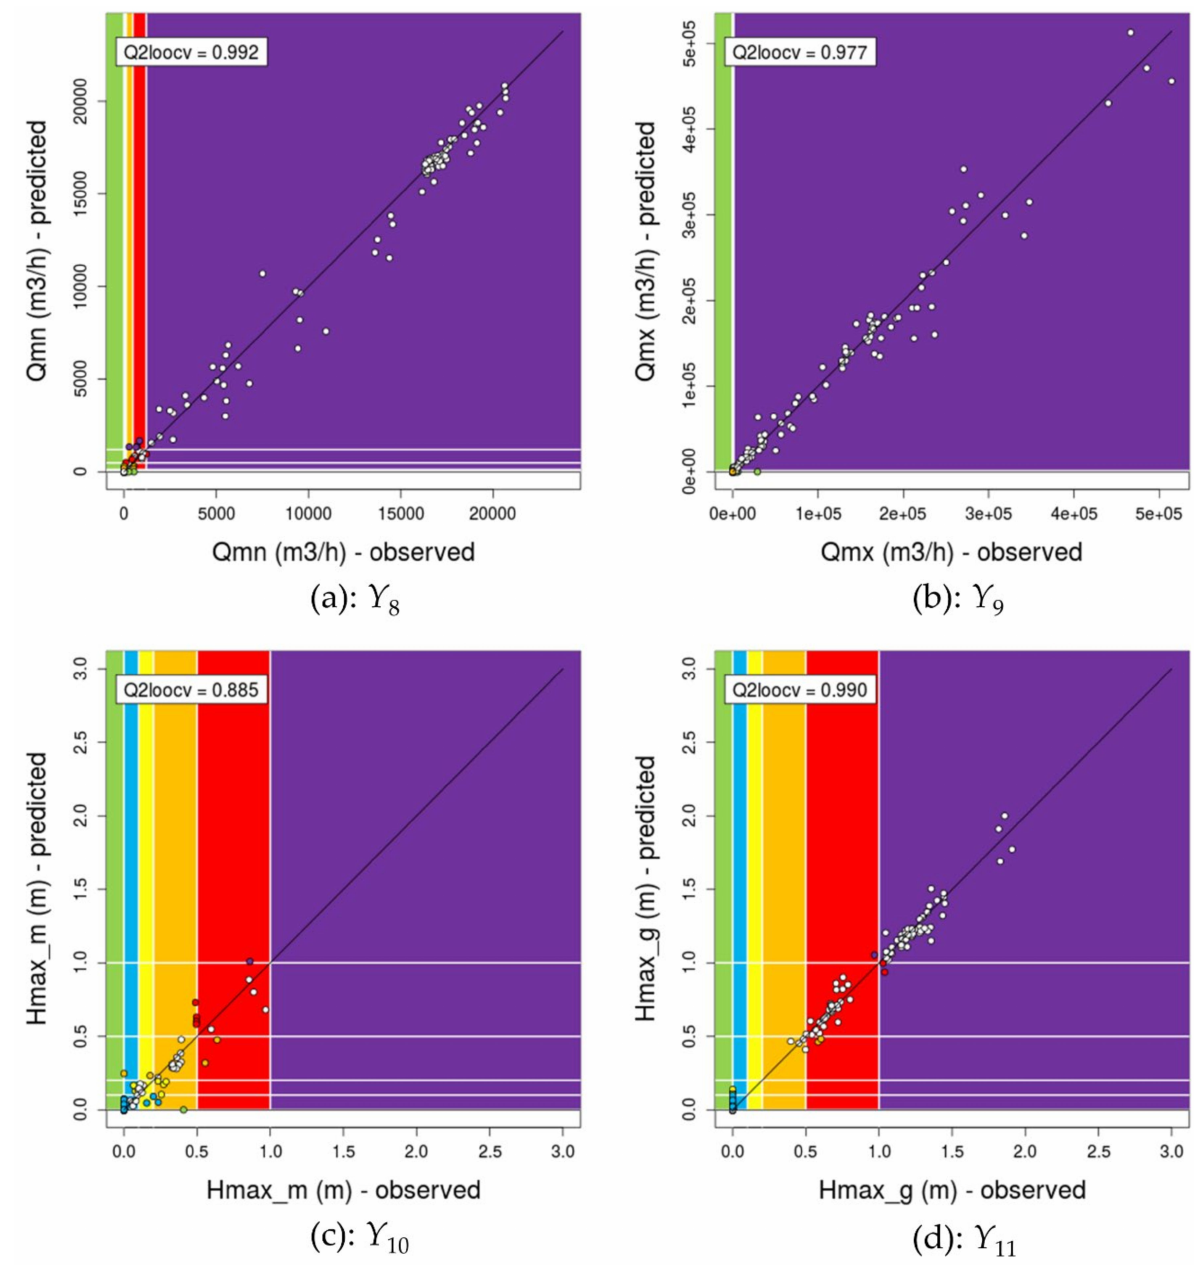
Figure A2. Cross-validation of the Y 8 –Y 11 metamodels: comparison between the observations (the numerically calculated Y values) and the predictions of the GP-based metamodels. The colour scales correspond to the colour scales of the indicators using these metamodels (see Figure 3 and Table